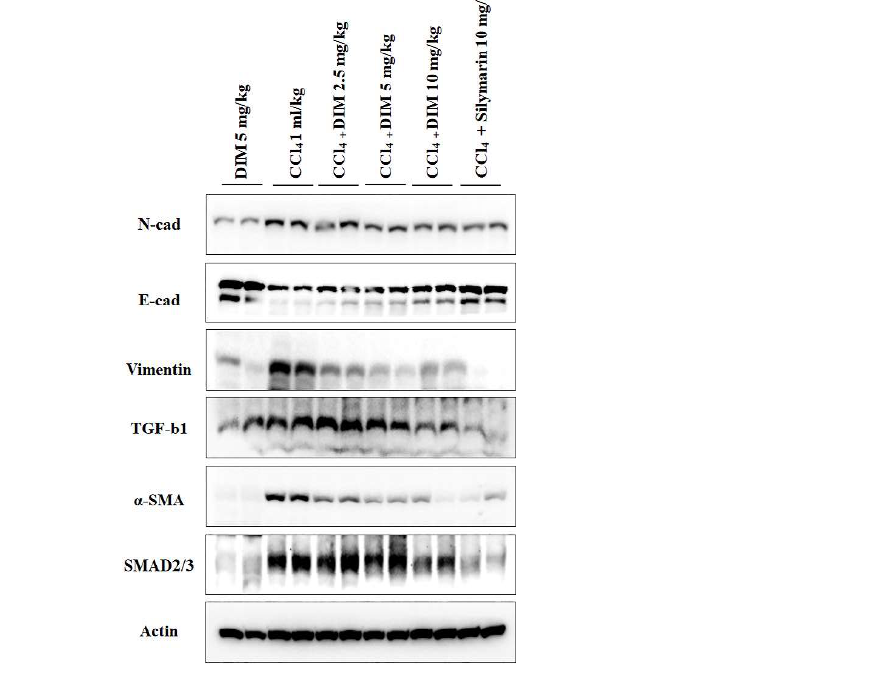
Figure 8. DIM attenuates CCl 4 -induced activation of EMT markers in mouse liver fibrosis. Protein expression levels of EMT markers (α-SMA, TGF-β1, and Smad 2/3) in liver were determined by immunoblotting.